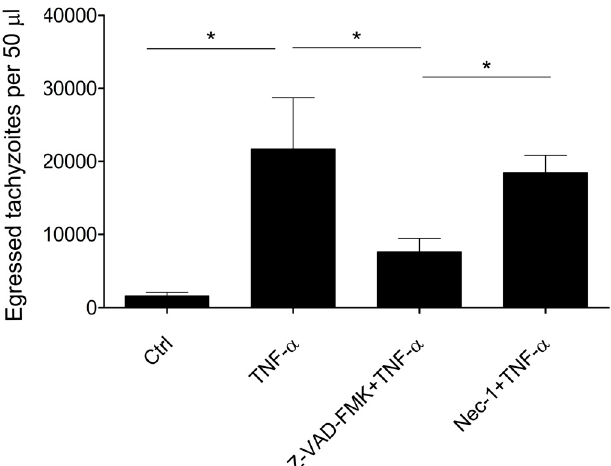
Figure 3. The host cell apoptosis pathway was involved in TNF- a -induced egress of T. gondii . Infected HFFs (36 h) were pre-treated with apoptosis inhibitor Z-VAD-FMK (10 m M, 20 min) or necroptosis inhibitor Nec-1 (20 m M, 20 min) before the TNF- a -induced egress assay. Bars represent means ± SDs of fi ve replicates. This experiment was repeated three times with similar results, * p < 0.05.